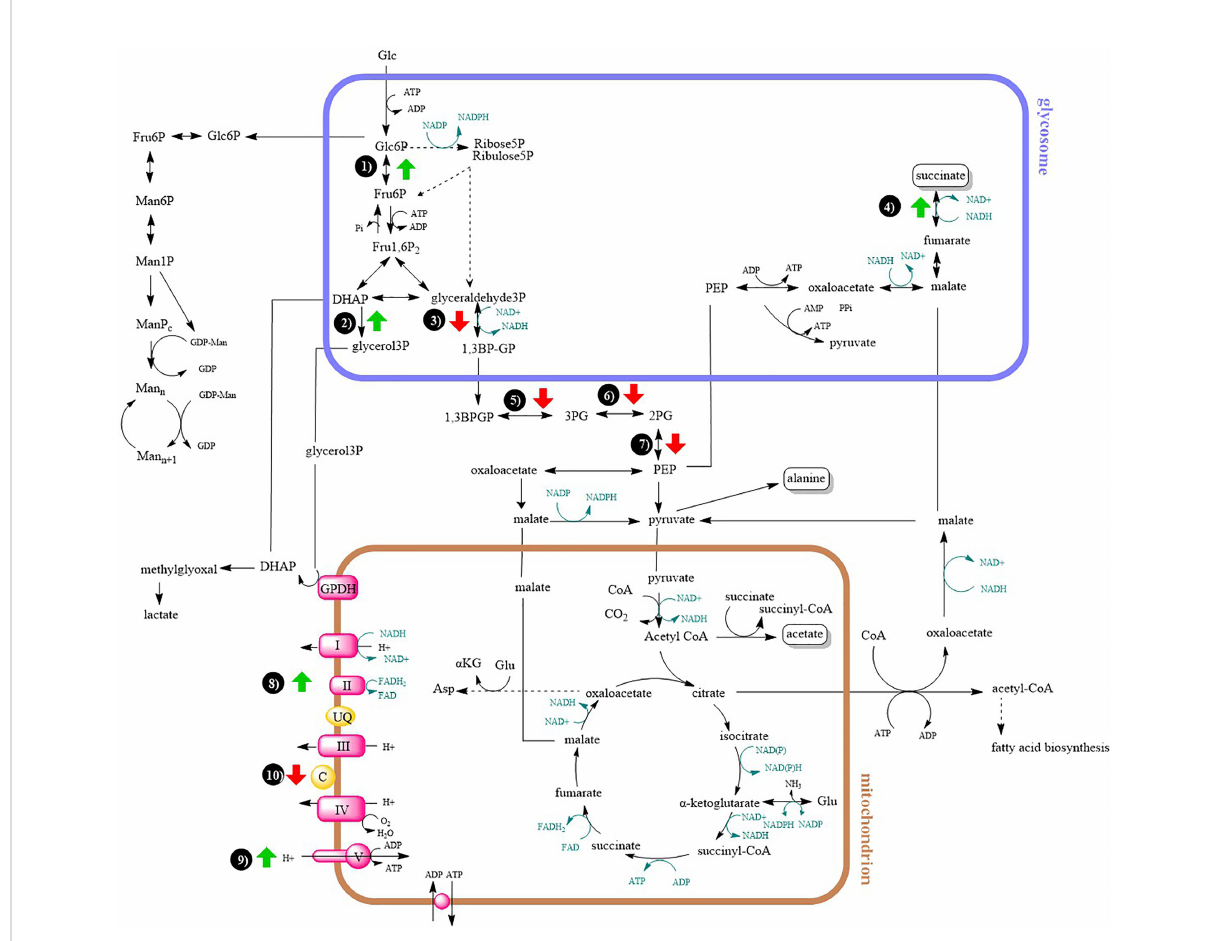
FIGURE 5 Metabolic map of central carbon metabolism and oxidative phosphorylation. Arrows indicates at least two-fold up- or downregulation (T-test signi fi cant) of enzyme in lesion-derived amastigotes compared to axenic amastigotes (macrophage-derived amastigotes are usually intermediate between the two). 1) glucose-6-phosphate isomerase 2) glycerol-3-phosphate dehydrogenase 3) glyceraldehyde-3-phosphate dehydrogenase 4) fumarate reductase 5) phosphoglycerate kinase 6) phosphoglycerate mutase 7) enolase 8) succinate dehydrogenase 9) ATP synthase 10) cytochrome